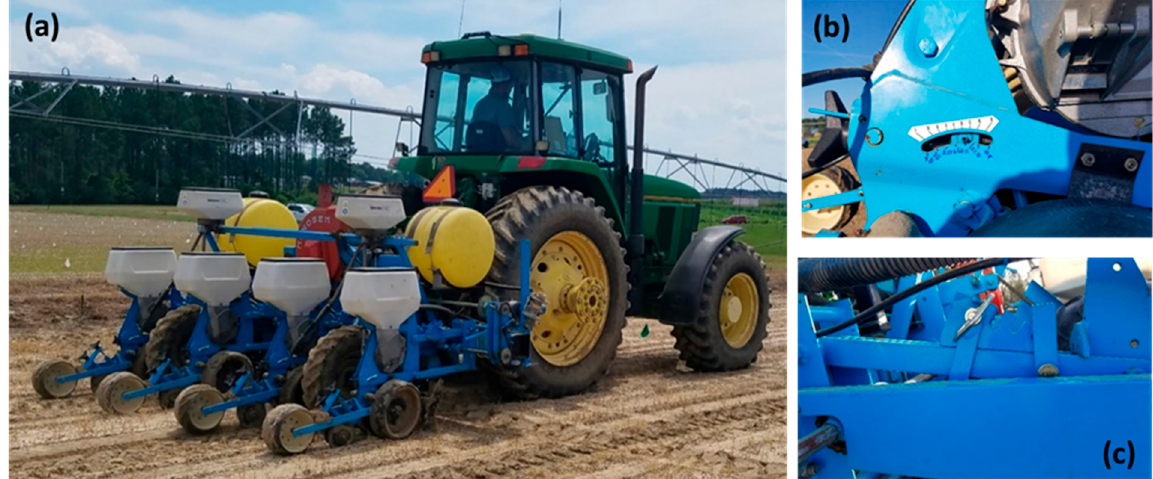
Figure 1. ( a ) Four-row Monosem NG Plus vacuum precision planter, ( b ) depth control mechanism, and ( c ) mechanical downforce assembly used for attaining different downforce adjustments in this study.